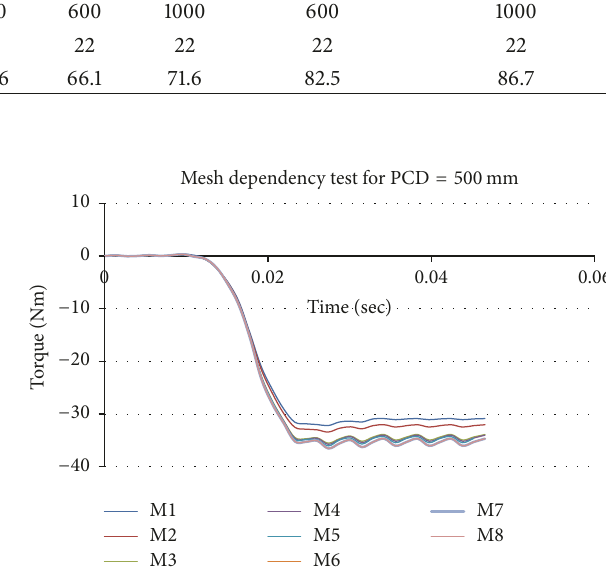
Figure 19: Total torque variations for different mesh sizes for PCD = 500 mm.